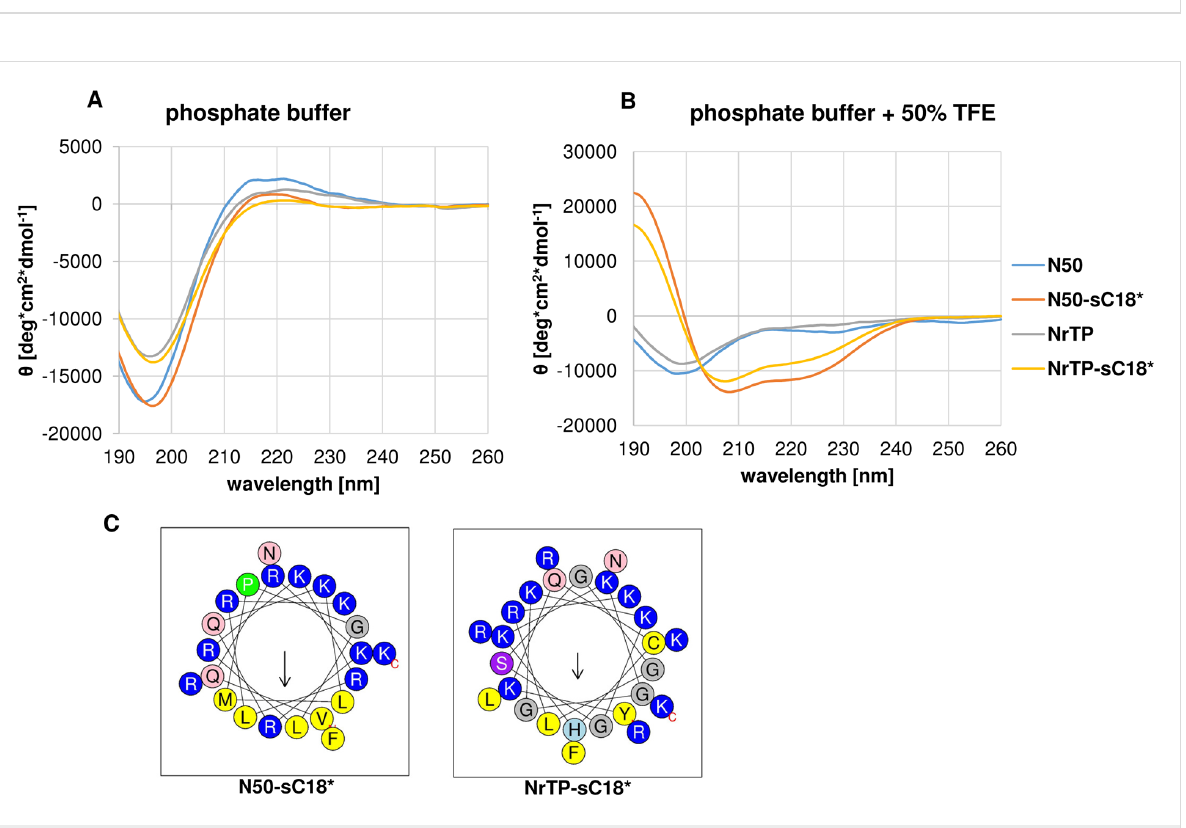
character with a clear hydrophilic and hydrophobic